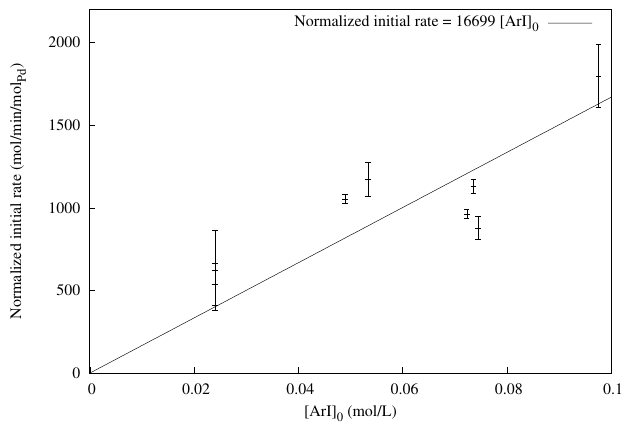
Figure 3. Effect of the initial concentration of 4-iodoacetophenone on the initial reaction rate. The initial rates are normalized by the mass of Pd. Conditions: 4-iodoacetophenone from 0.025 to 0.10 mol/L, phenylboronic acid (0.06 mol/L), MeONa (0.075 mol/L), Pd (5.10 − 6 mol/L), and ethanol (20 mL), 60 ◦ C.